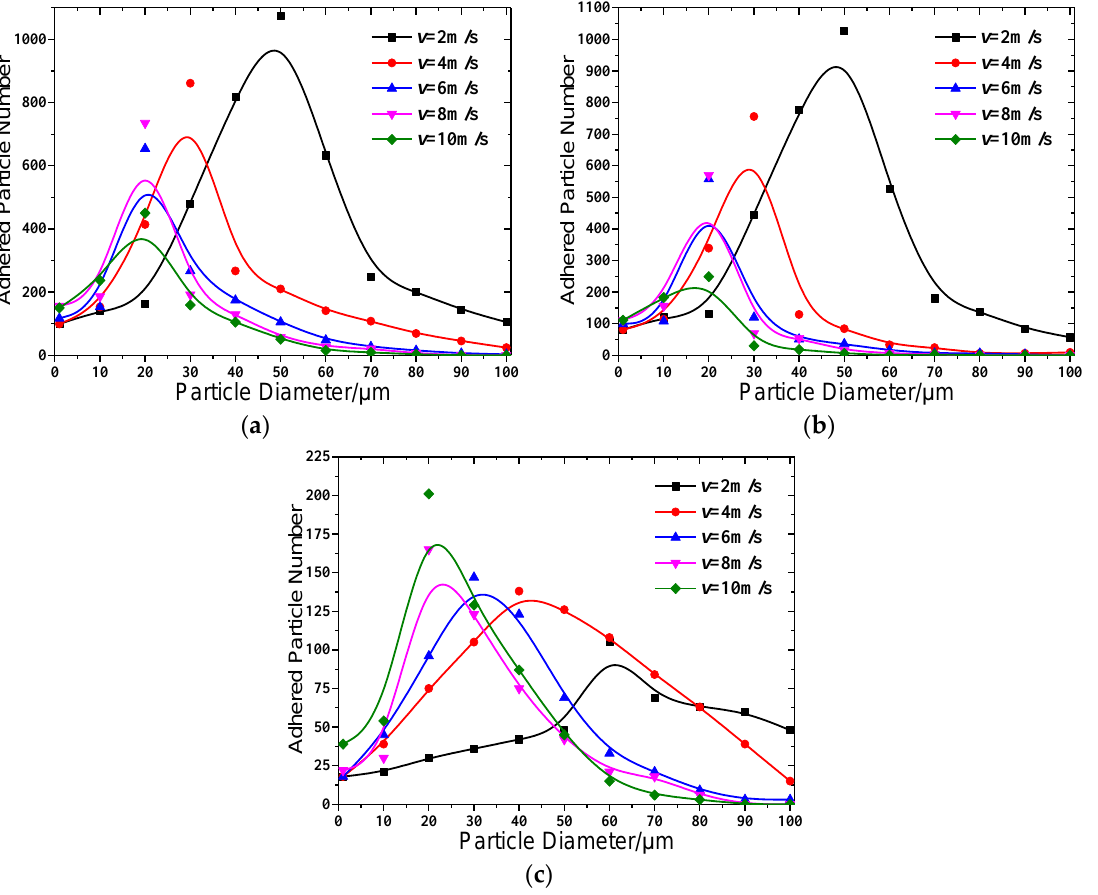
Figure 6. Adhesion number of particle with different size under different wind speed: ( a ) all surface; ( b ) upper surface; and ( c ) bottom surface.